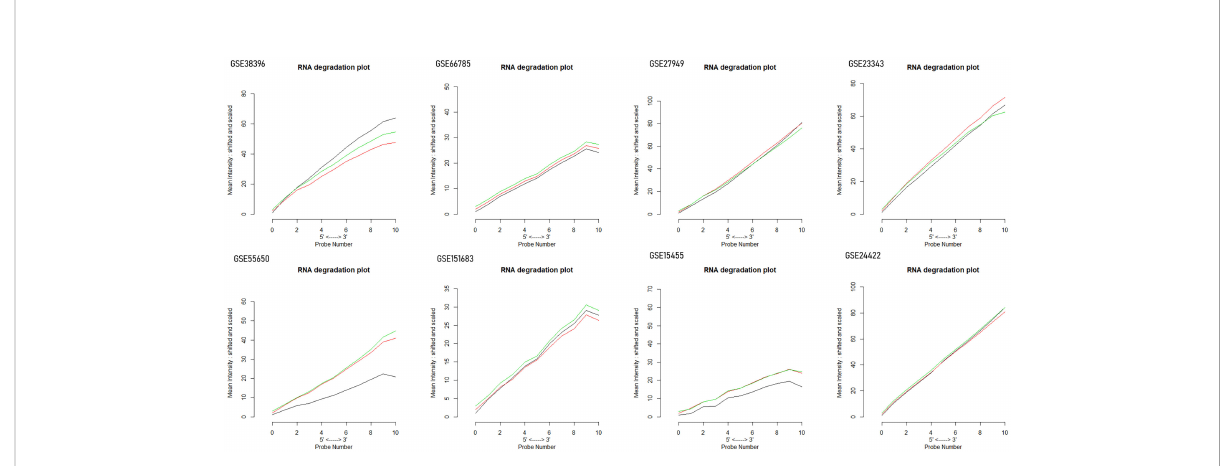
FIGURE 2 RNA degradation plots obtained by the plot AffyRNAdeg package of R demonstrating RNA quality and severity of